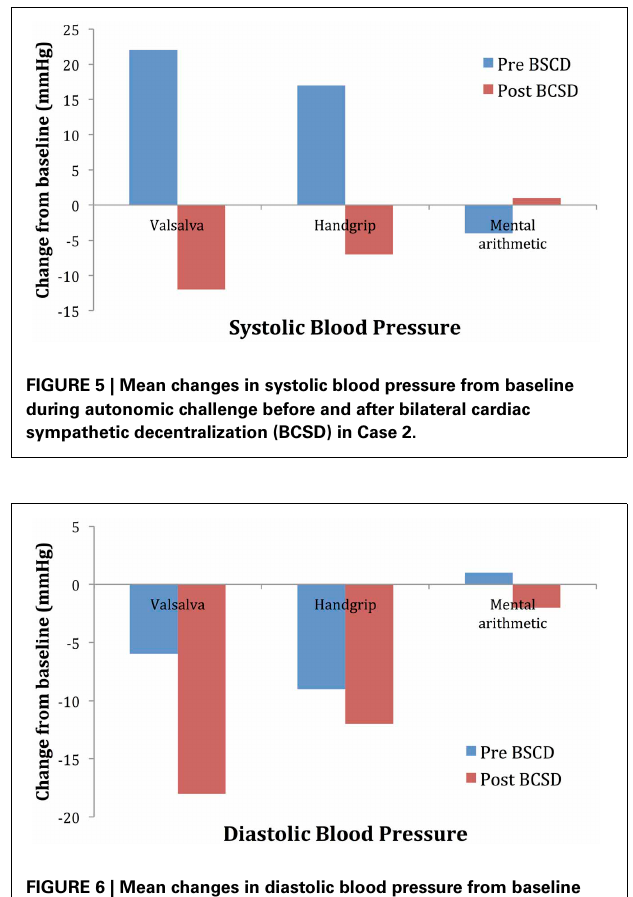
FIGURE 6 | Mean changes in diastolic blood pressure from baseline during autonomic challenge before and after bilateral cardiac sympathetic decentralization (BCSD) in Case 2.